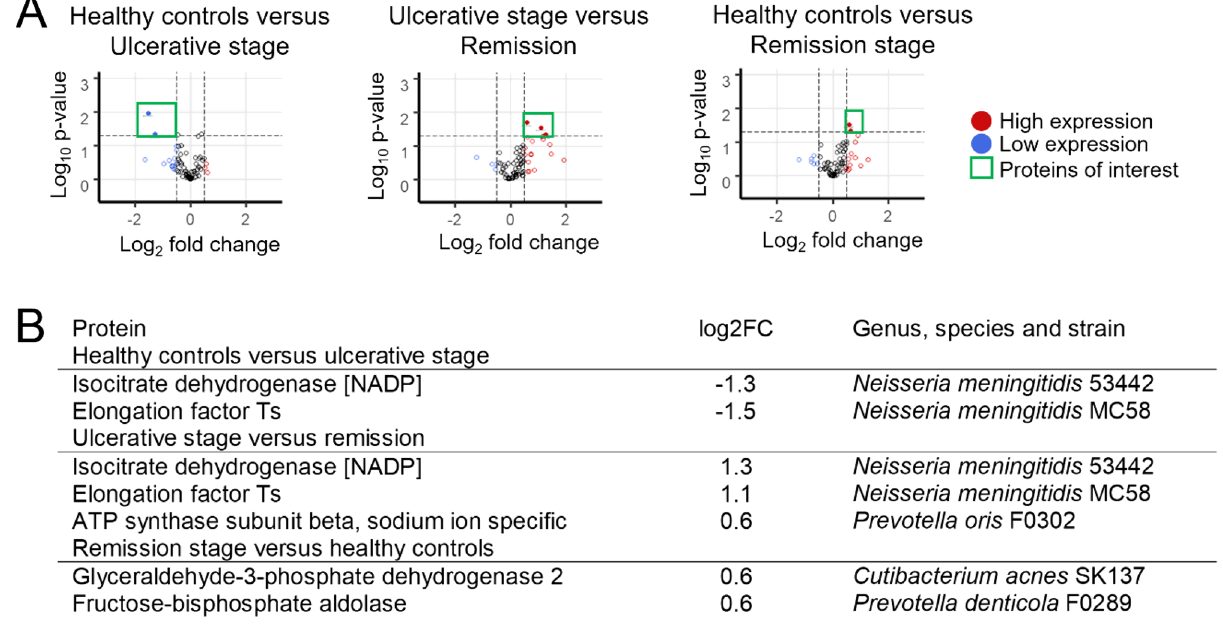
Figure 5. Presence of recurrent aphthous ulcers reveals Neisseria meningitidis proteins. ( A ) Volcano graphs show the windows considered in the analysis, constructed considering statistical significance and fold change. Proteins up- and down-regulated are enclosed by a green square. Fold change limits were − 0.5 and 0.5. The established p value was 0.05. ( B ) Table details the proteins expressed differentially in the comparison between groups. The presence of proteins and strains of Neisseria meningitidis (serogroup B, strain MC58 and serogroup C, strain 053442) during ulcerative activity stands out. Information of oral bacteria was obtained from The Human Oral Microbiome Database (http:// www. homd.